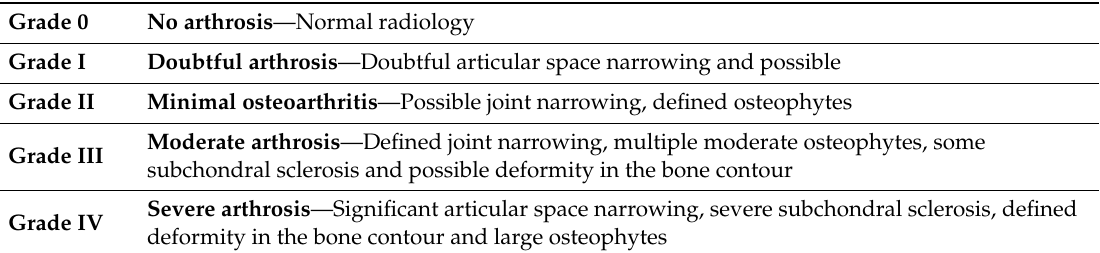
Table 3. Classification of Kellgren–Lawrence.